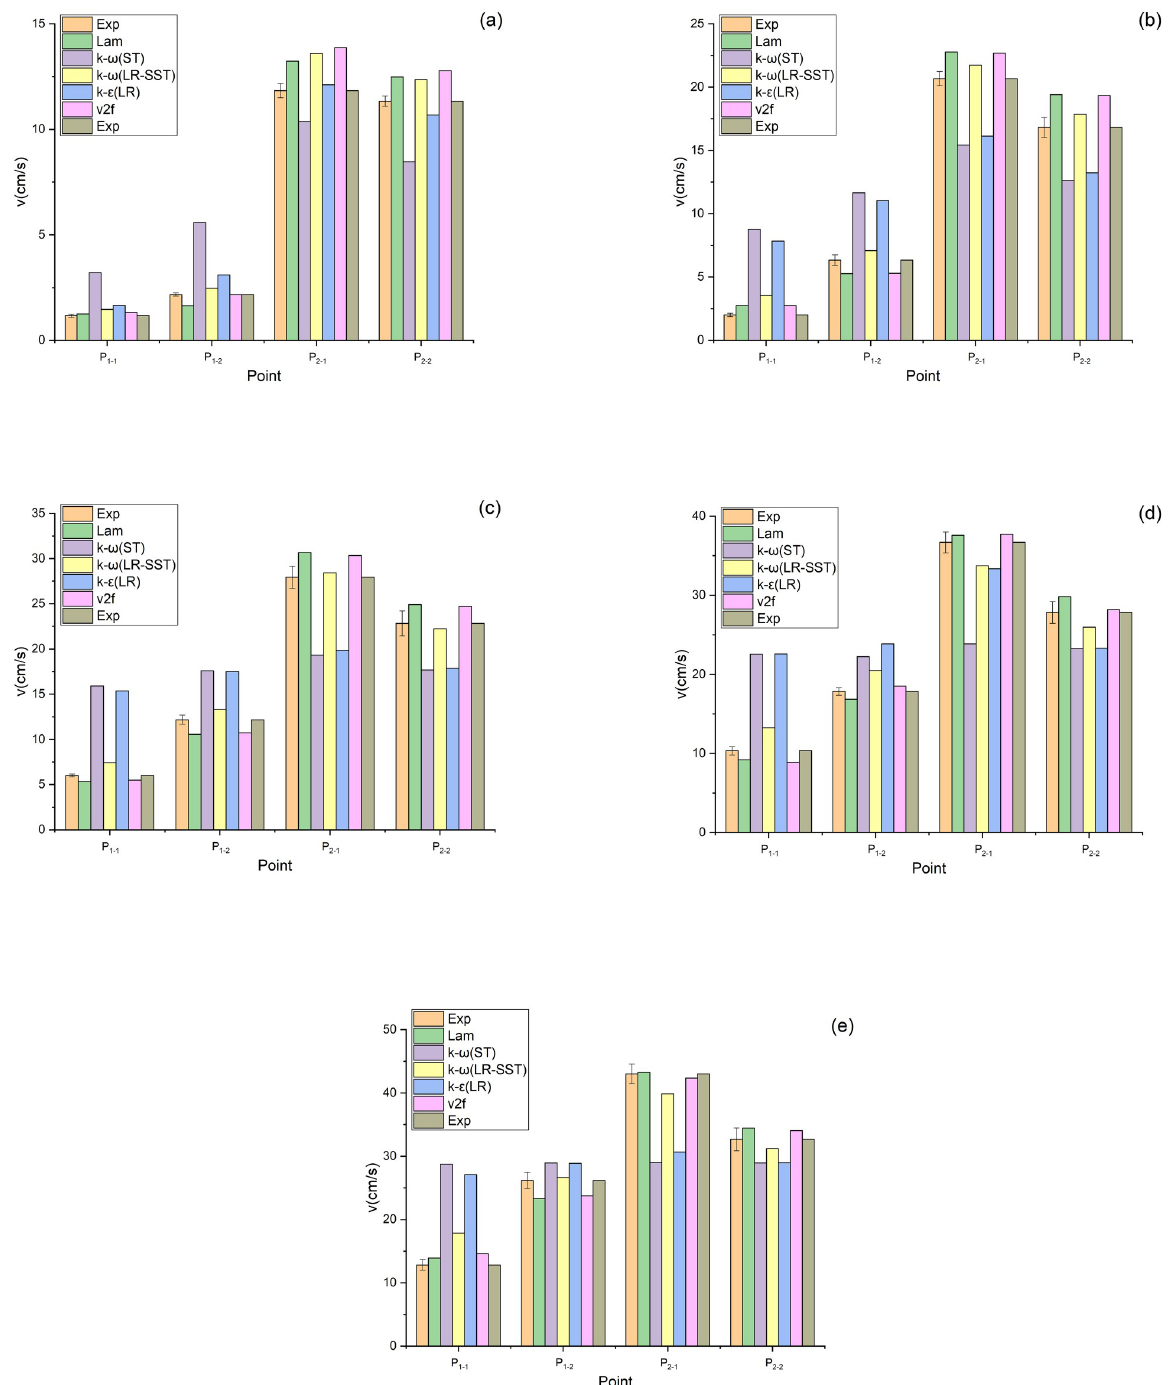
Fig 10. Air velocities of the V-shaped filters at measuring points under different CFD models (a) α = 0.71, (b) α = 1.43, (c) α = 2.14, (d) α = 2.86, (e) α = 3.57.